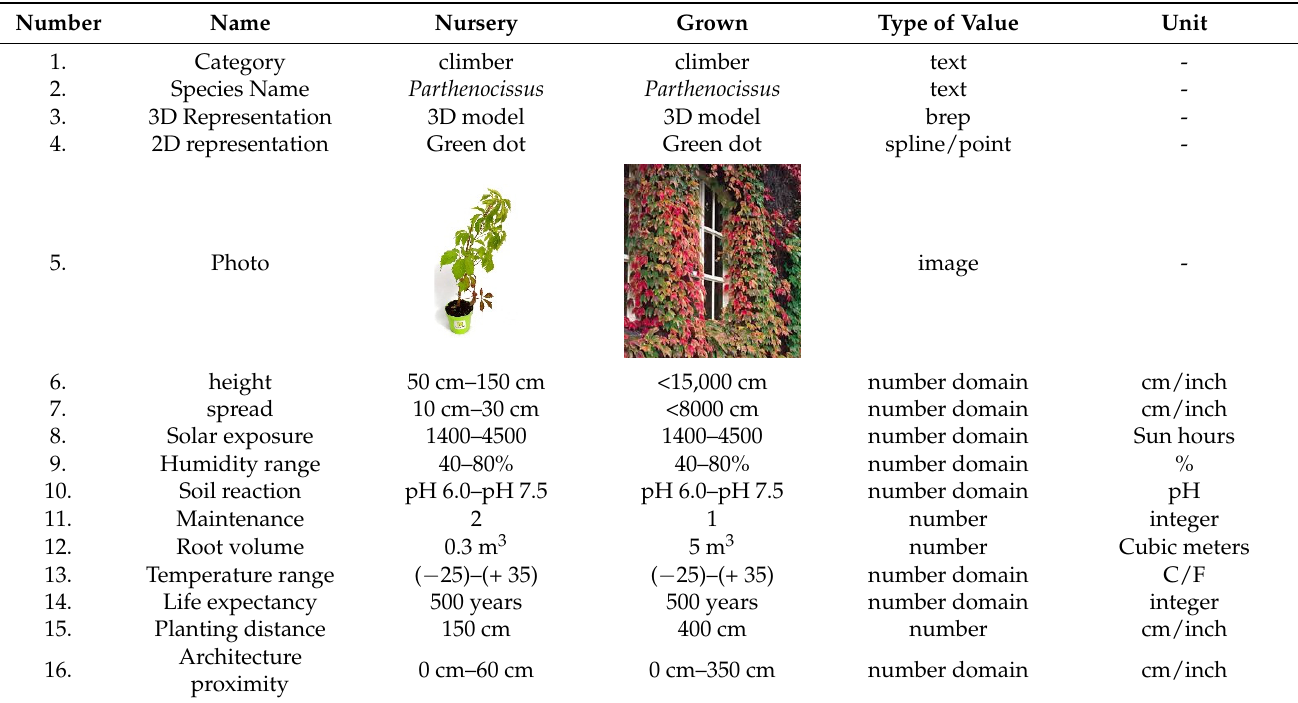
Table 1. Selected greenery parameters (SGP) for Parthenocissus .